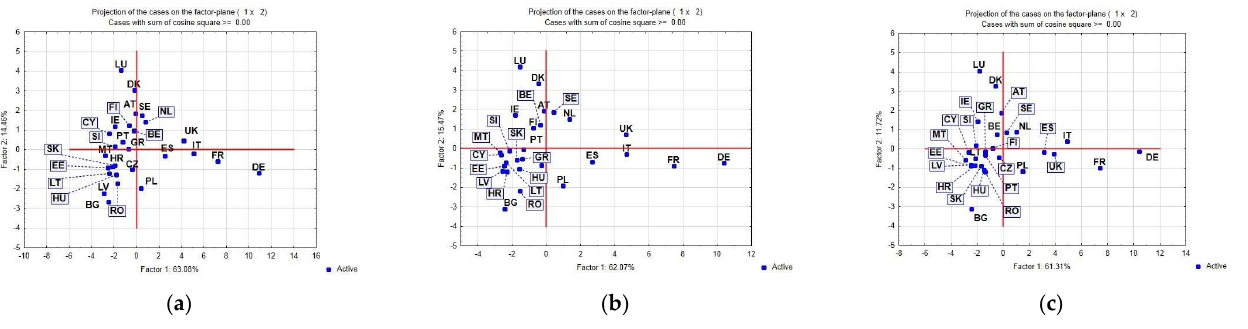
Figure 3. The distribution of energy consumption variability of EU countries in the space of the first two main components for ( a ) 2010, ( b ) 2015, and ( c ) 2019. Source: Own study based on the Statistica 13.3